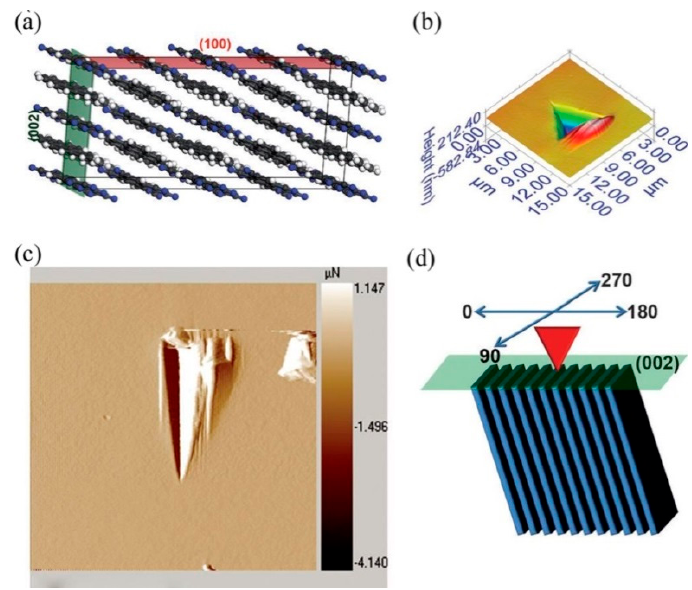
Figure 17. TCNB–pyrene complex. ( a ) Crystal packing. The major and minor faces are shown in red and green colored slabs. ( b ) Residual indent impression on the (002) showing pile-up only on one side of the indenter. ( c ) AFM scan image 25 µm in size, showing layer migration (towards the right direction only) upon nanoscratching. ( d ) Schematic representation of the indenter movement and layer arrangement. (Reproduced with permission from Wiley-VCH, Reference 108). Crystals 2017 , 7 , 324